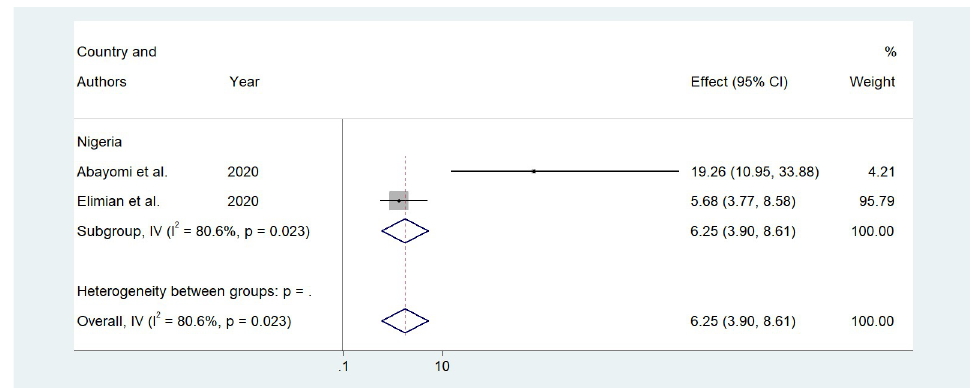
Fig 9. Forest plot showing the estimate for the effects of dyspnea on COVID-19 mortality.